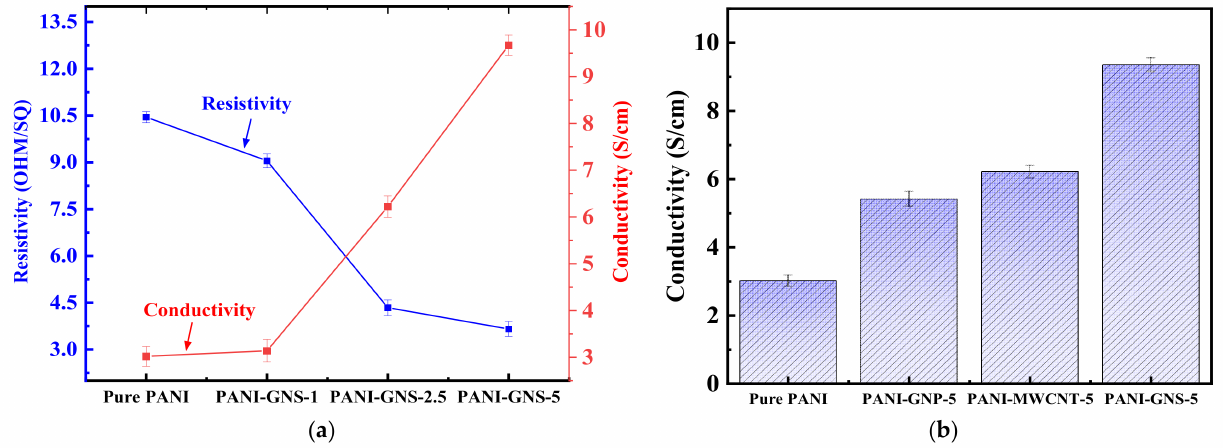
Figure 5. Electrical properties of PANI/CSA electrodes ( a ) at different GNS content, ( b ) in presence of different